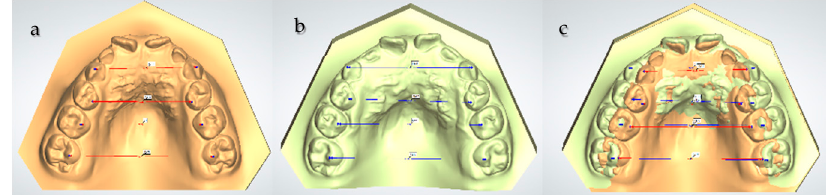
Figure 5. Control Group—RME: Mandibular arch before ( a ), after the expansion ( b ) and the superimposition of the two digital casts ( c ).